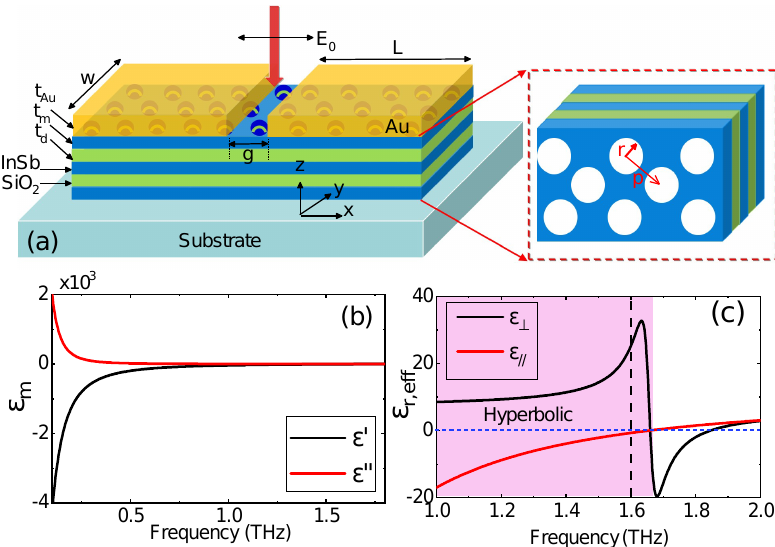
Figure 1. ( a ) Schematic of the proposed approach to further enhance the near fields of a terahertz dipole antenna composed of two metal stripes. A hyperbolic metamaterial (HMM) dressed with periodic hole arrays (inset) is sandwiched between the substrate and the dipole antenna. The HMM is composed of alternating layers of InSb (in blue) and SiO 2 (in green) with thicknesses of t m and t d , respectively. A terahertz plane wave polarized in x direction with unitary amplitude normally impinges onto the structure. ( b ) Frequency-dependent complex relative permittivity of InSb at THz frequencies, which is calculated using the Drude model. ( c ) Real parts of the effective relative permittivity tensor components of the InSb-SiO 2 multilayer metamaterial according to the effective media theory. The purple region indicates that the metamaterial has hyperbolic dispersion